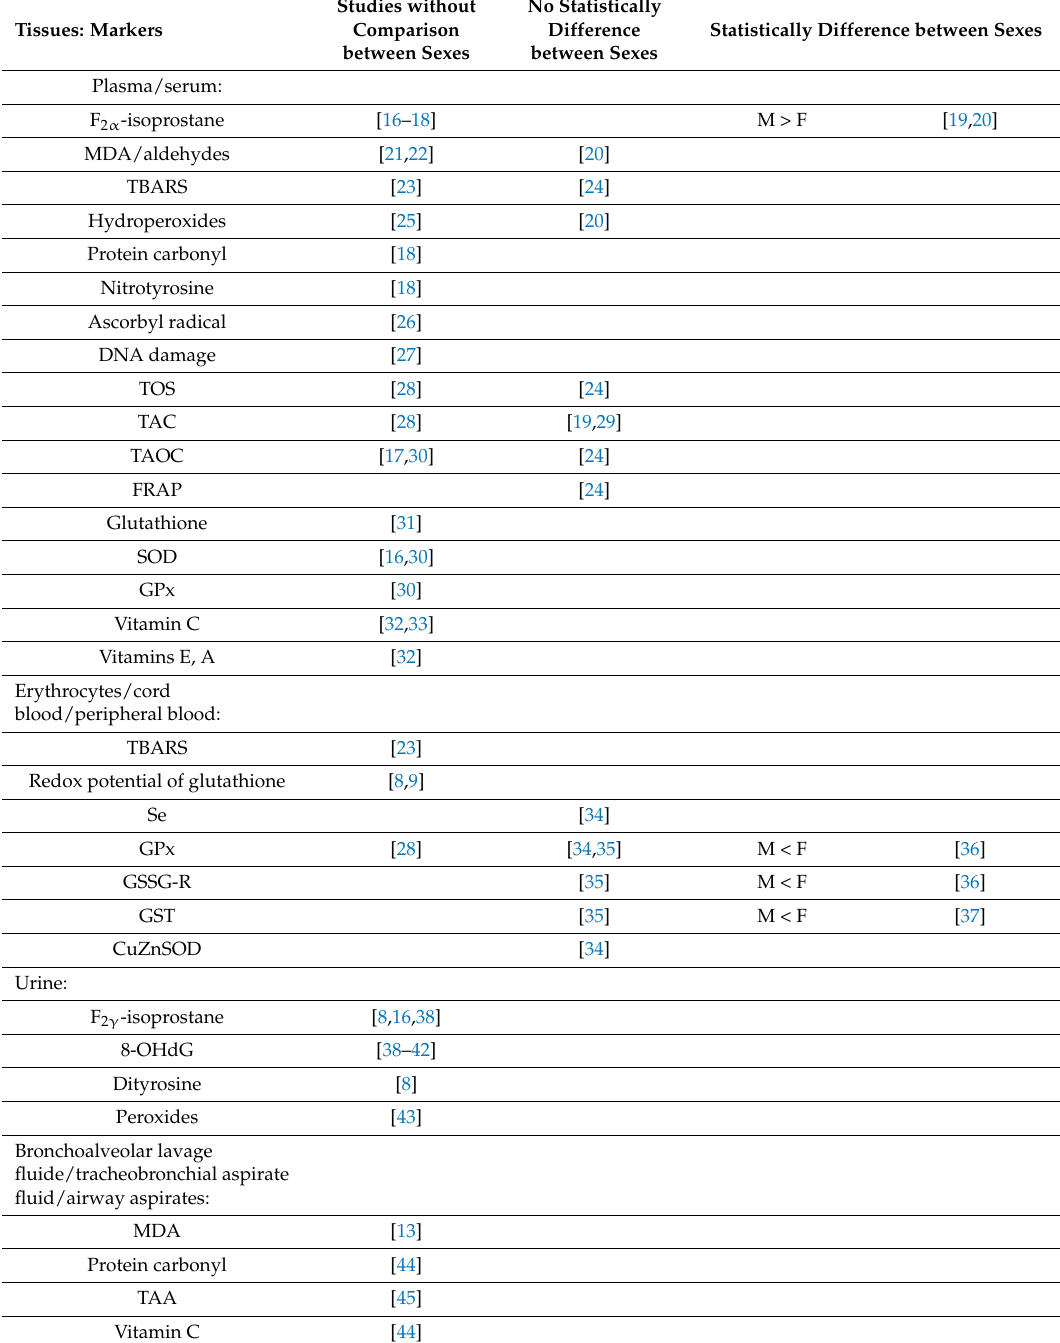
Table 1. Studies in function of the type of comparisons reported between